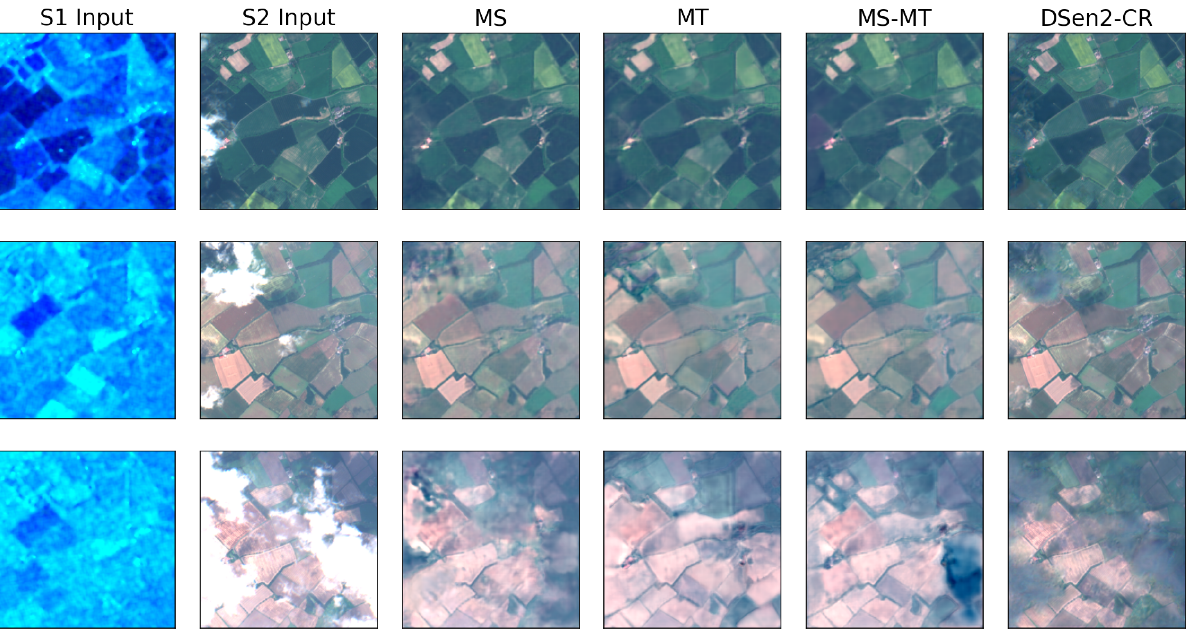
Figure 11. Results on the blind cloud removal task, with no available clear sky references for the Scotland region. The cloud masks were annotated manually to enable a comparison with the DSen2- CR external